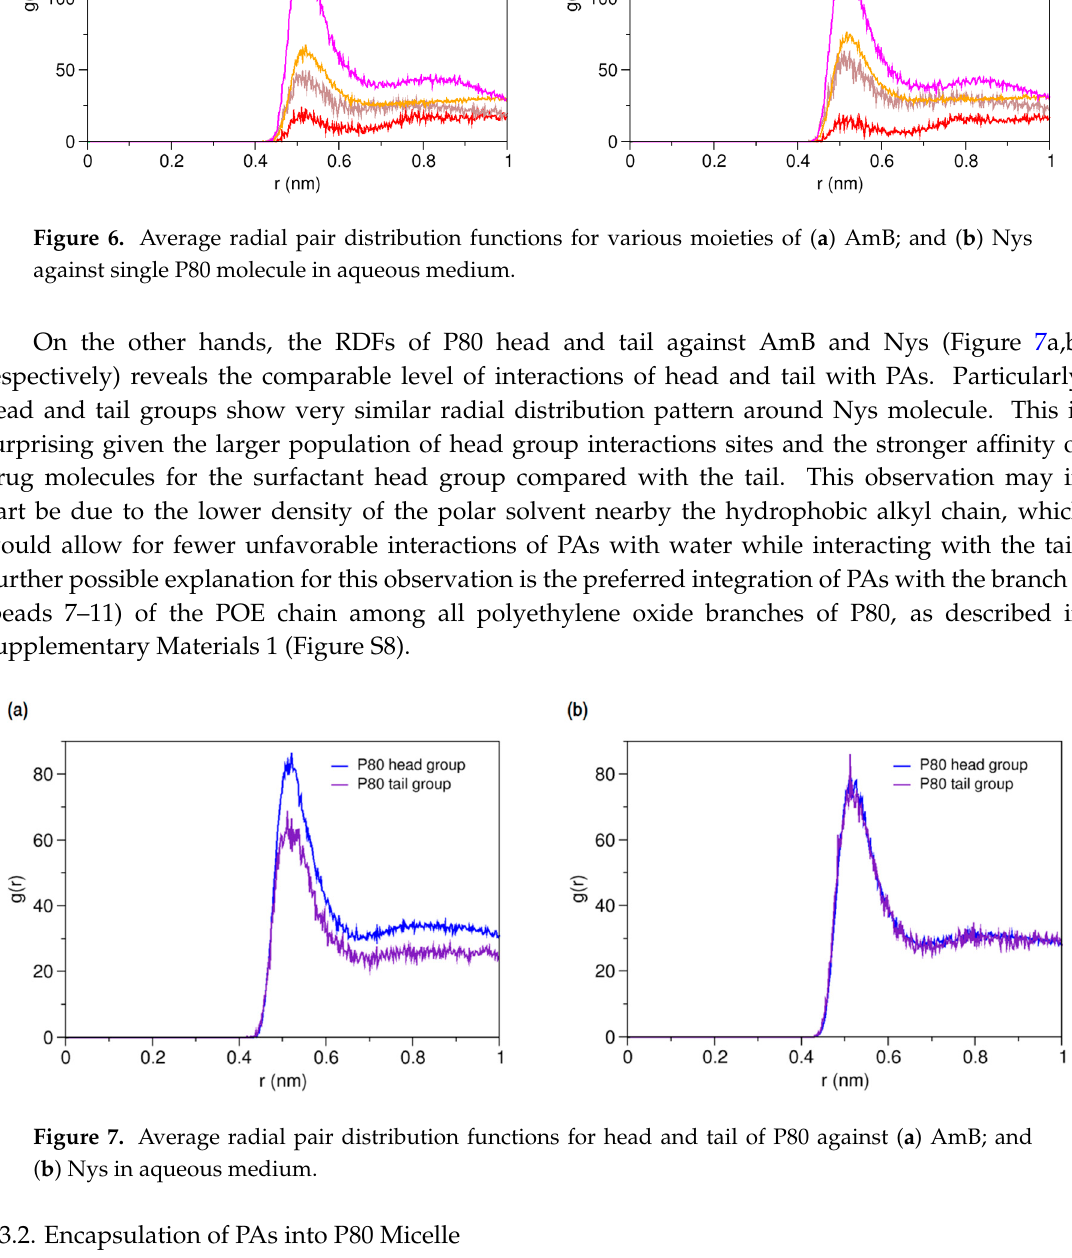
Figure 8. Average radial pair distribution functions for different molecular groups of ( a ) P80-AmB mixed micelle; and ( b ) P80-Nys mixed micelle against water particles. The hydration level of PAs in the micelle falls in-between that of P80 head and tail groups. In comparison with the free state (Figure 5), the hydration of the polyol and polyene chains of PAs in the micelle is significantly limited. However, the charged groups of PAs are more strongly hydrated than the surfactant head. The above figure represents a competition between hydrophobic and hydrophilic moieties of PAs to modulate the interactions of the encapsulated drugs with water, leading to the dynamic residence of the PAs in micelle. To quantify the net dynamics of PAs within the micelle phase, the 3-dimentional and lateral diffusion coefficients of the entrapped drug molecules were calculated by eliminating contributions of translation of the COM and rotation of